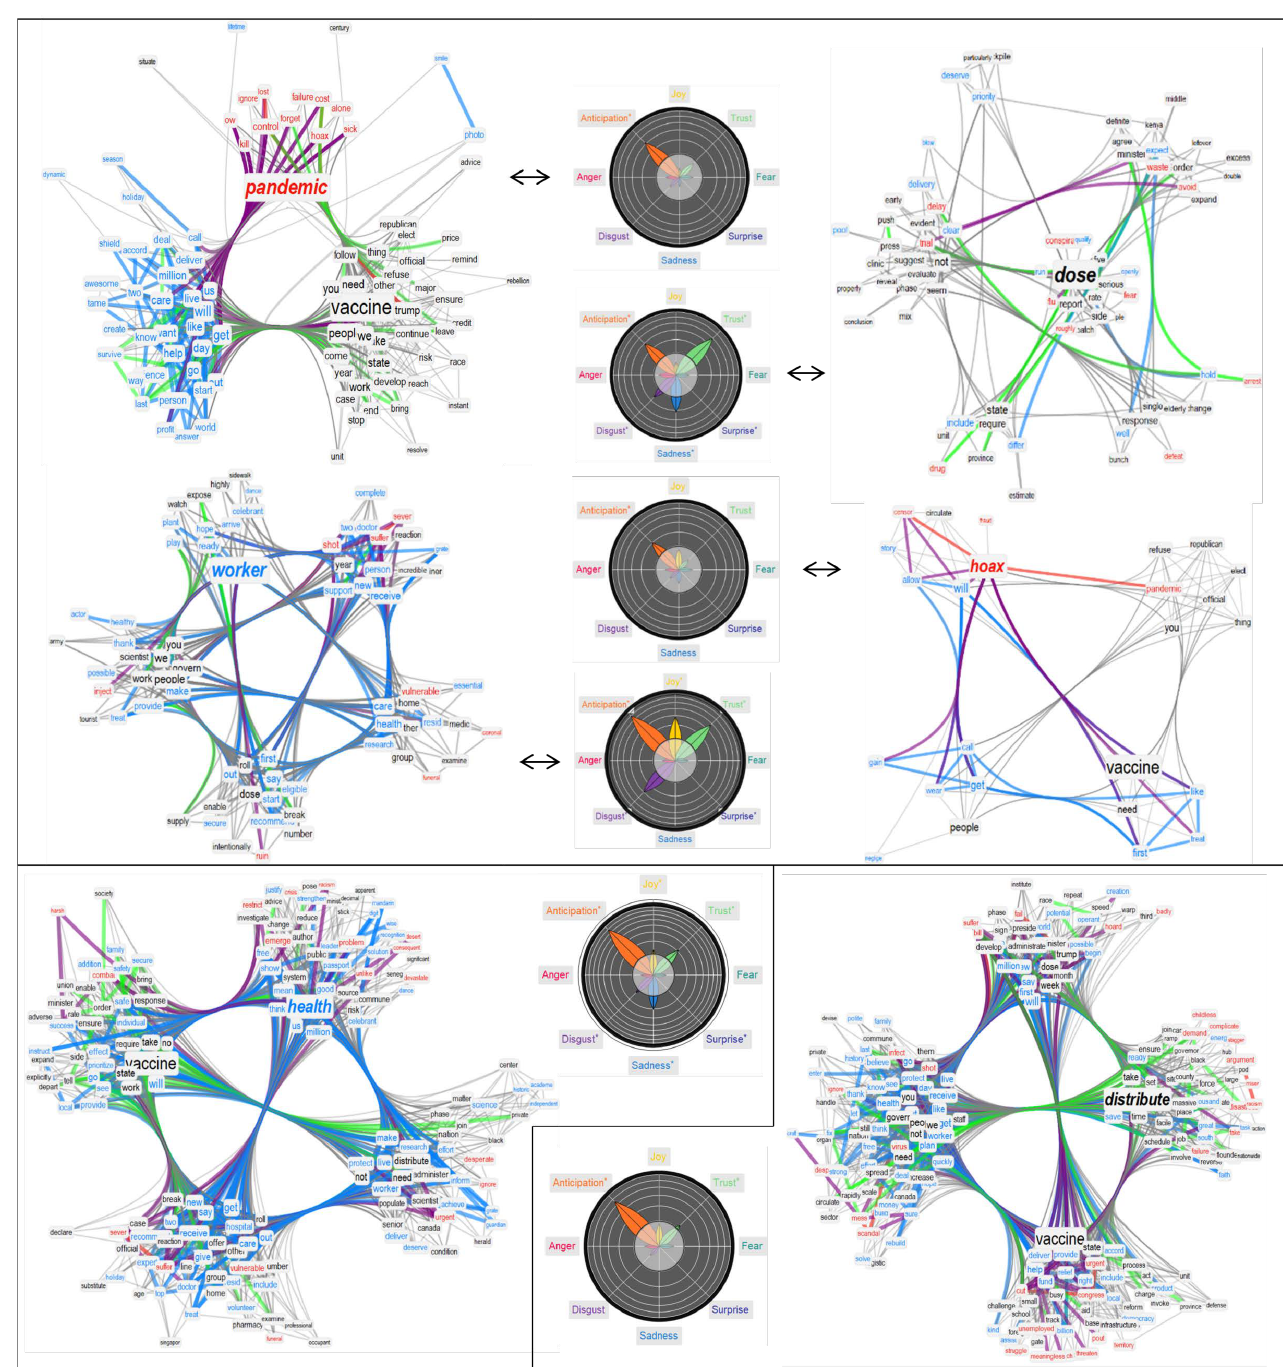
Figure 4. TFMNs capturing conceptual associations in social discourse around “pandemic”, “dose”, “worker” and “hoax” ( top ) and around “health” and “distribute” ( bottom ). Positive (negative) concepts are cyan (red). Neutral concepts are in blue. Associations between positive (negative) concepts are highlighted in cyan. Purple links connect concepts of opposite valence. Green links indicate overlap in meaning. The emotional flowers indicate how rich the reported neighbourhoods are in terms of emotional jargon. Petals falling outside of the inner circle indicate a richness that differs from random expectation at α = 0.05. Each ring outside of the circle corresponds to one unit of z -score. Asterisks highlight emotions z >